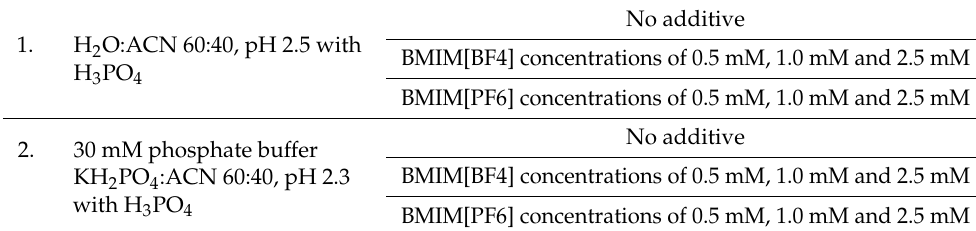
Table 2. Experimental design regarding the mobile phase